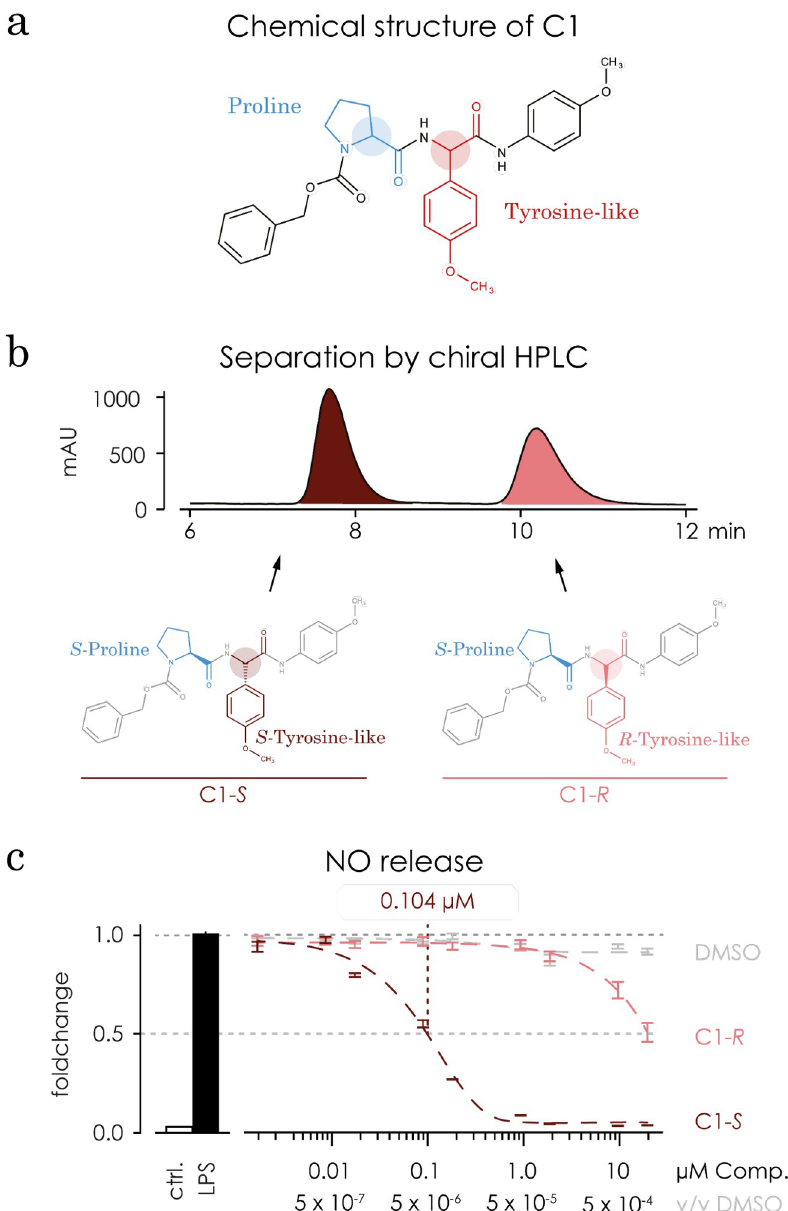
Fig 6. C1 exists in 2 stereoisomers. a) C1’s structure inherits 2 stereo centres, both located in the backbone of the peptide bonds, one in the amino acid proline (shown in blue) and the other one in the amino acid phenylglycine (shown in red). The stereo centre in proline amino acid is defined in its S configuration. The stereo centre in the amino acid phenylglyicne is not defined and consists of both S and R configurations. Both configurations are shown below on b. b) The stereoisomeric mixture of C1 was separated into its stereoisomers using a chiral HPLC, resulting in two distinct peaks. The area under the curve for both peaks are 43% (shown in dark red, C1- S ) and 57% (shown in light red, C1- R ) in relation to the total area. c) Repeating the assays shown in Fig 2 the stereoisomers C1- S (in dark red) and C1- R (in light red) showed different effects on the NO release compared to C1, but not in the metabolic activity or NO scavenging. Microglia were treated with C1- S , C1- R or DMSO for 1 hour followed by an additional stimulation with 1 μ g/mL LPS for 48 hours. The concentration of the compounds ranged from 0.0002 μ M to 20 μ M and for DMOS (in grey) from 0.6x10 -6 v/v up to 1x10 -3 v/v. The NO concentration was tested using a Griess assay. The calculated IC 50 value for C1- S was 104 nM (95% CI = 0.09491 to 0.1152) and for C1- R 43.29 μ M (95% CI = 8.841 to